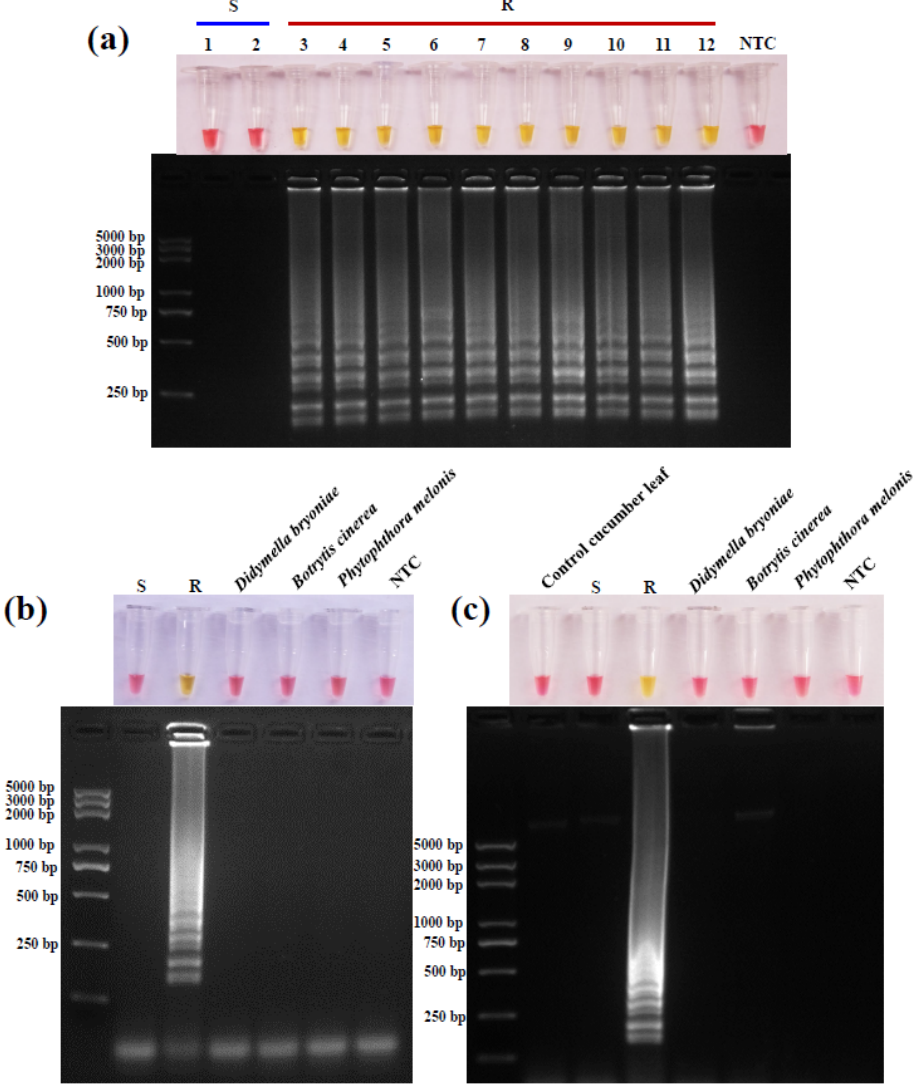
Figure 6. Specificity of LAMP assay for the G143A mutation in the Cyt b gene of Corynespora cassiicola or other causal agents ( Didymella bryoniae , Botrytis cinerea , and Phytophthora melonis ) that cause common cucumber diseases. Genomic DNA of mycelia ( a , b ) or infected cucumber leaves ( c ) of four important pathogens. “S”, pyraclostrobin-sensitive C. cassiicola isolates (Cc4, Cc10); “R”, pyraclostrobin-resistant C. cassiicola isolates (Cc21, Cc23, Cc31, Cc35, Cc42, Cc53, Cc71, Cc66, Cc96, Cc123). “NTC”, negative control using dH 2 O as reaction template.